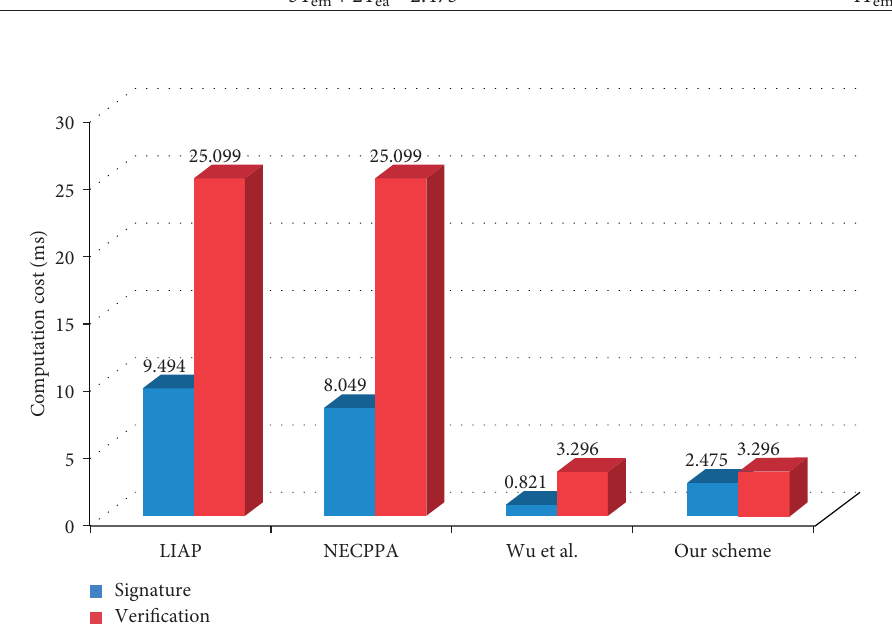
Figure 3: Comparison of computation